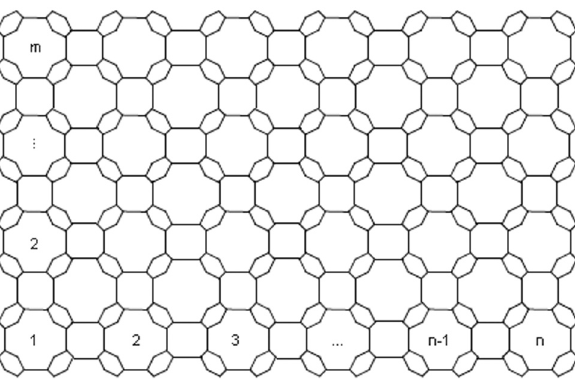
Figure 1: Molecular graph of ( ) P m n , .